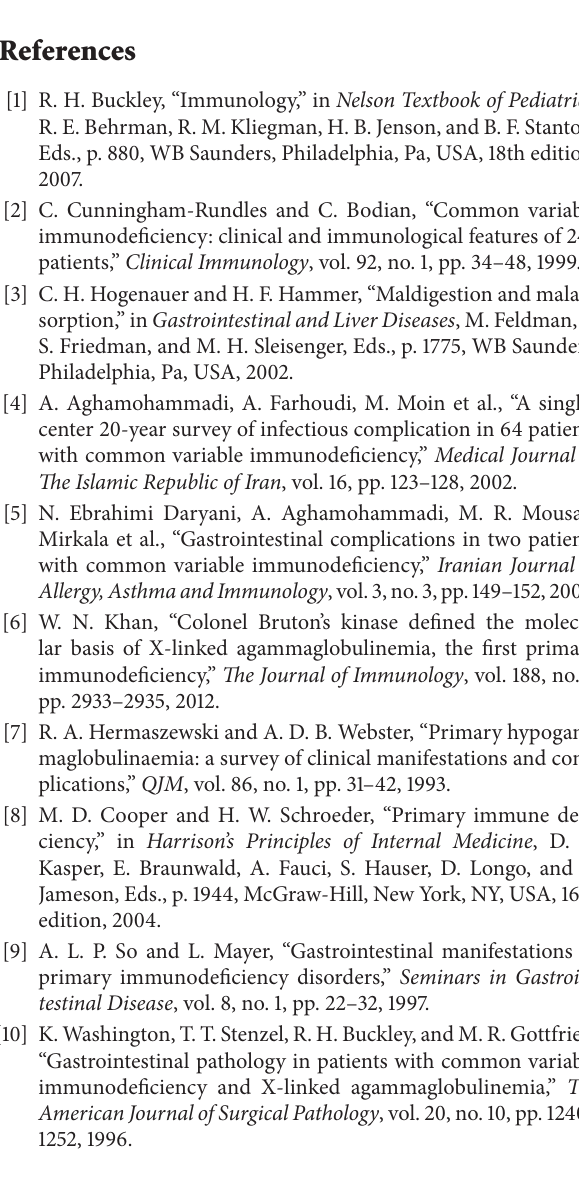
Figure 2: Multiple small polyps in D2 part of duodenum.